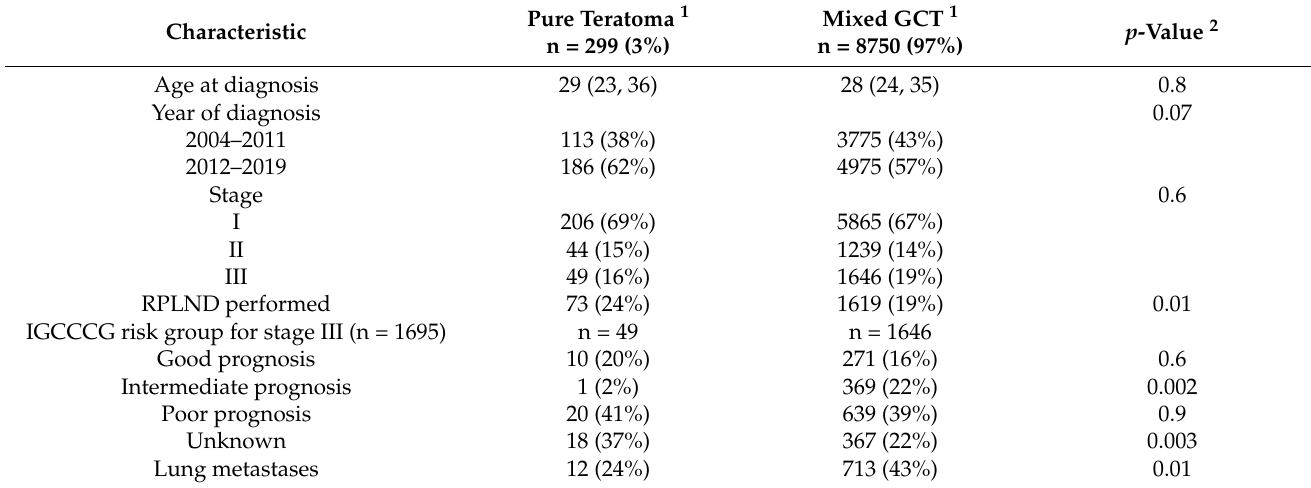
Table 1. Baseline characteristics of 9049 patients with pure teratoma and mixed germ cell tumor (GCT) within the Surveillance, Epidemiology and End Results (SEER) database